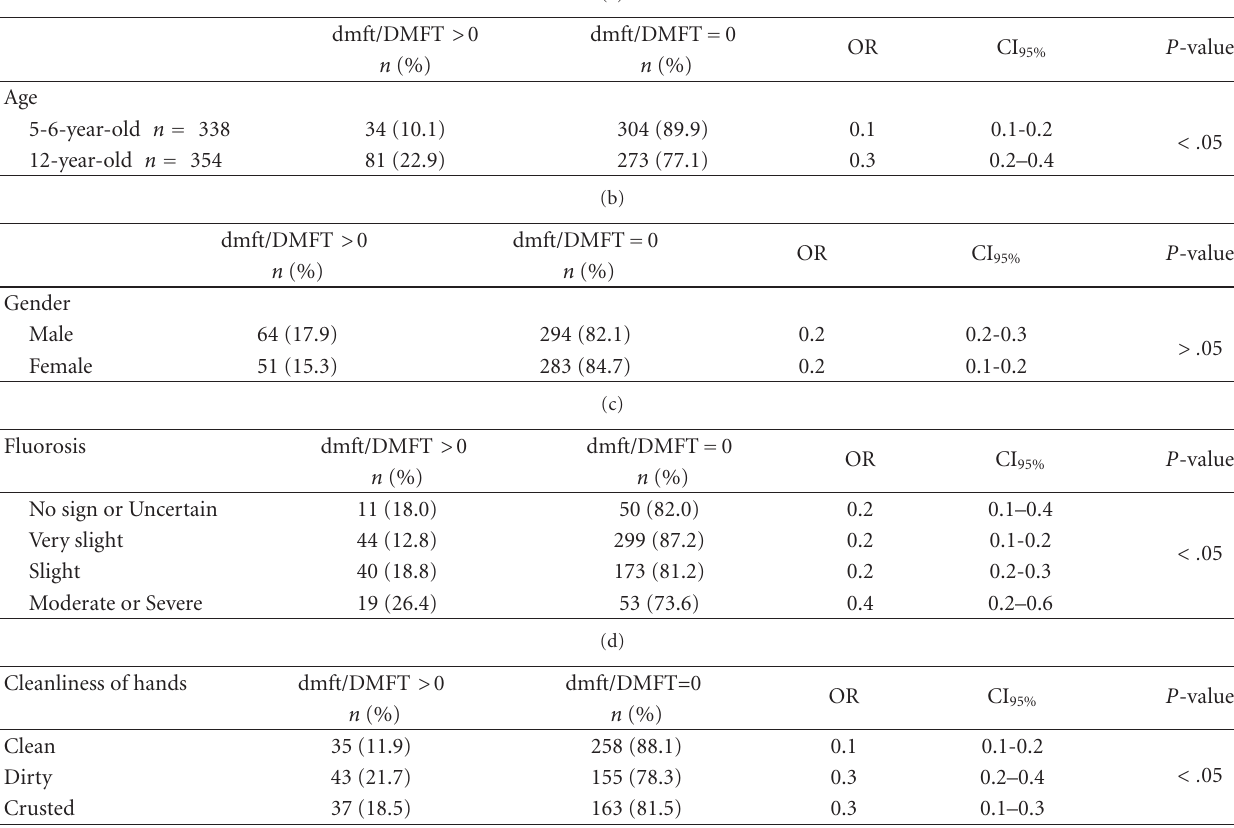
Table 1: Caries experience by age, gender, fluorosis, and cleanliness of hands as count (percent in row) and odds ratio (OR) for each category.